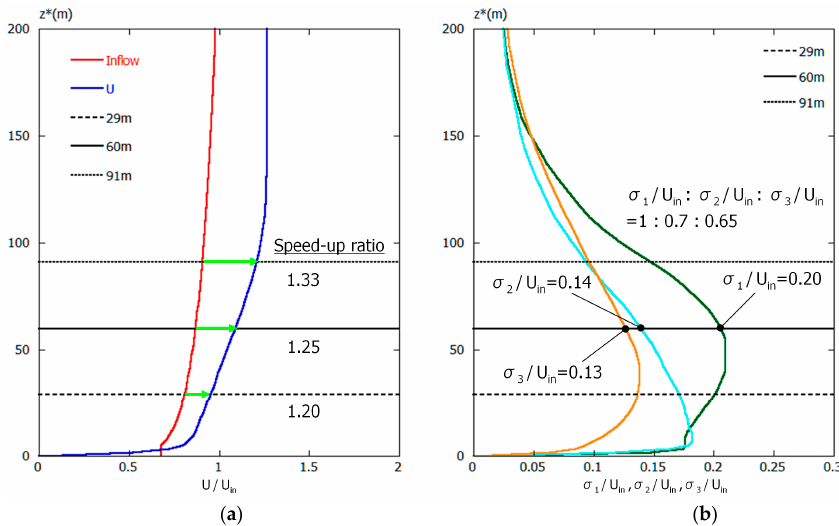
Figure 12. Vertical profiles of statistical quantities of the turbulent flow at the site of T7. ( a ) Normalized mean streamwise wind velocity; ( b ) Normalized standard deviation of the three wind velocity components. (U in : the inflow streamwise wind velocity at the height of the maximum surface elevation in the computational domain. z*(m): the height above the ground.)